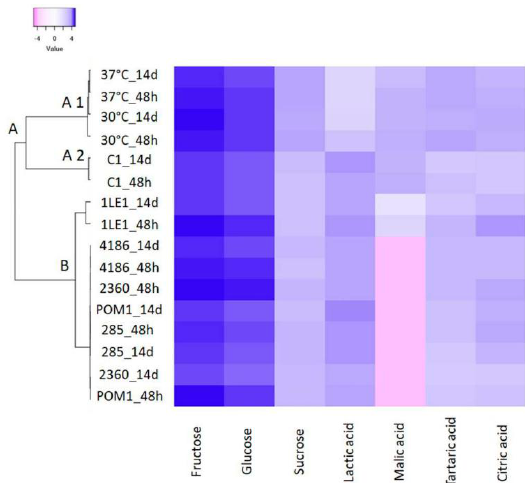
Figure 2. Sugars and organic acid metabolism. Hierarchical clustering and heat map performed on sugars and organic acids detected in fermented juice with L. plantarum (C1, 1LE1, POM1 and 285), L. rhamnosus (2360) and L. paracasei (4186) and unfermented juice (30 ◦ C and 37 ◦ C) after fermentation (48 h) and storage (14 days). A scale ranging from a maximum of 4 (blue) and a minimum of − 4 (pink) was